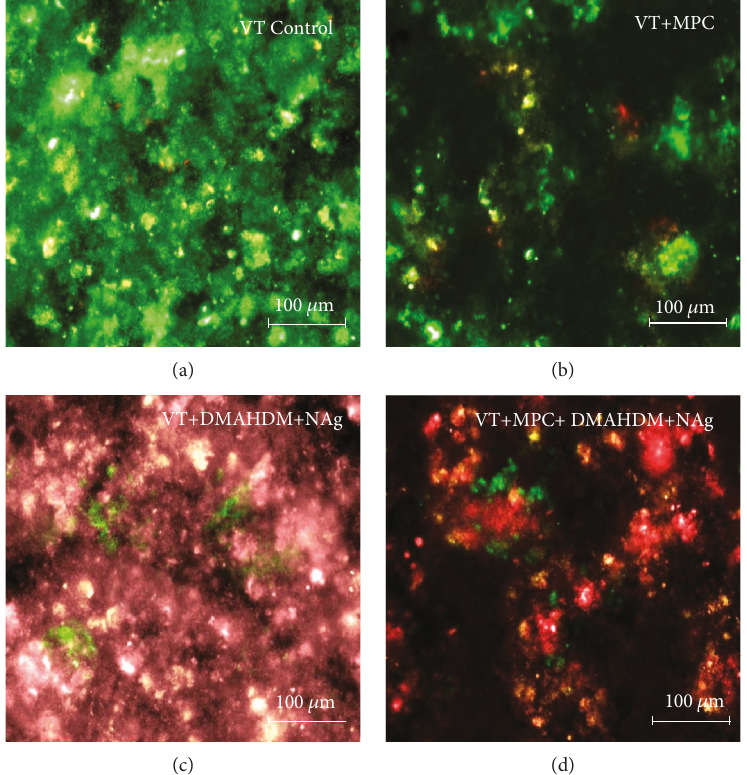
Figure 3: Representative live/dead staining images of 2-day bio fi lms grown on disks: (a) VT control, (b) VT with 3% MPC, (c) VT with 1.5% DMAHDM+0.1% NAg, and (d) VT with 3% MPC+1.5% DMAHDM+0.1% NAg. Live bacteria were stained green, and compromised bacteria were stained red. When live and dead bacteria were in close proximity or on the top of each other, the staining had yellow or orange colors. The VT with 3% MPC+1.5% DMAHDM+0.1% NAg had less bacterial adhesion, and the bio fi lms consisted of primarily compromised bacteria. (Adapted from reference [38], with